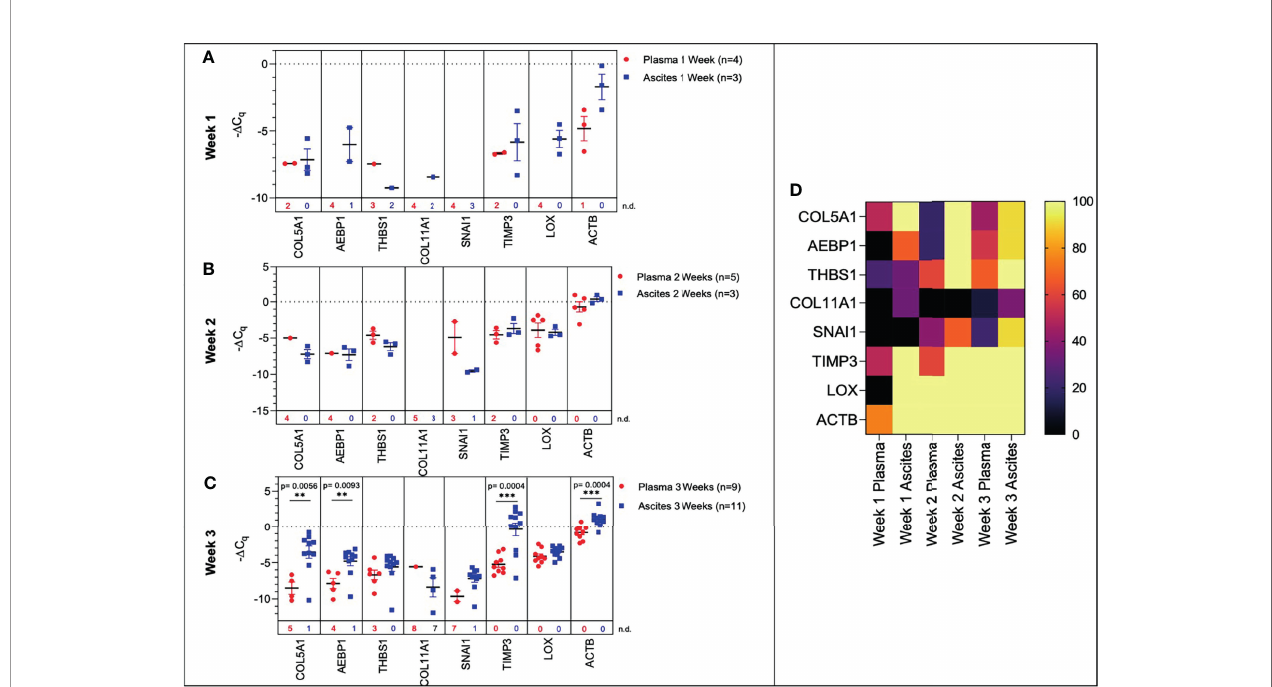
FIGURE 6 | Comparison of plasma-derived and ascites-derived sEV gene expression in a mouse model of ovarian cancer. Scatter plot of D C q values for plasma- derived and ascites-derived sEVs at: (A) Week 1 plasma (red, n=4) and ascites (blue, n=3); (B) Week 2 plasma (red, n=5) and ascites (blue, n=3); (C) Week 3 plasma (red, n=9) and ascites (blue, n=11). (D) Heat map showing the percentage of detected C q values over Weeks 1-3 indicates the absence/presence of the target gene in each experimental group. p values for unpaired two-tailed t-test are labeled in the graphs. The number of non-detected (n.d.) C q values in each experimental group are listed underneath the corresponding scatter plots. *p<0.05, **p<0.01, ***p<0.001,